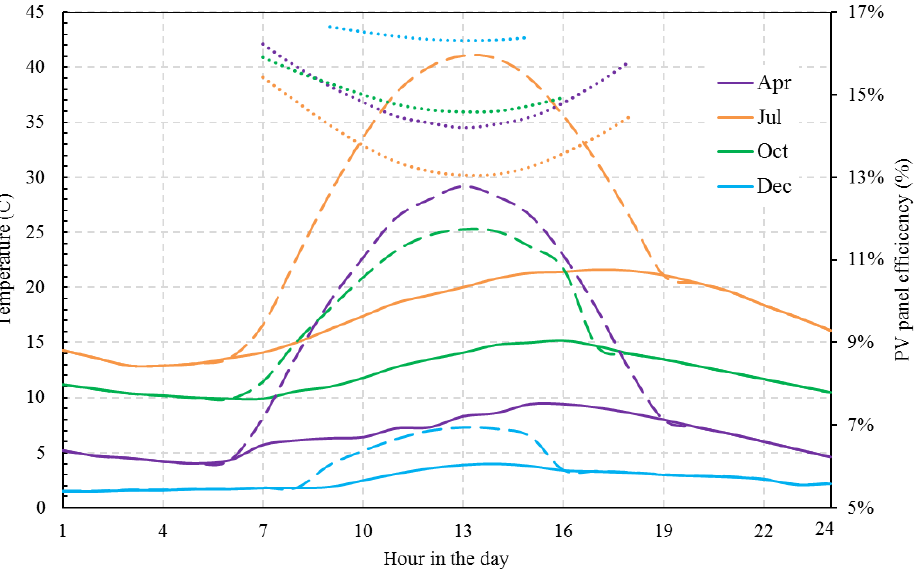
Figure 6. Hour-by-hour average of ( ) outdoor air temperature, ( ) the corresponding cell temperature of the PV module, along with ( ) the matching PV panel efficiency.